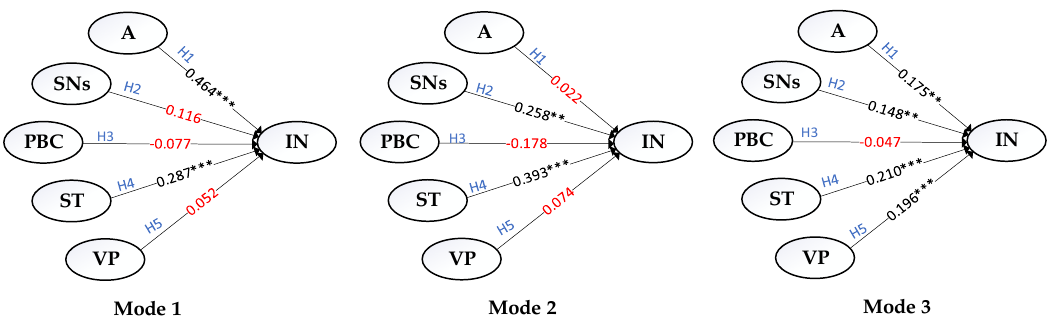
Figure 4. Path coefficient in the three pro-environmental publicity